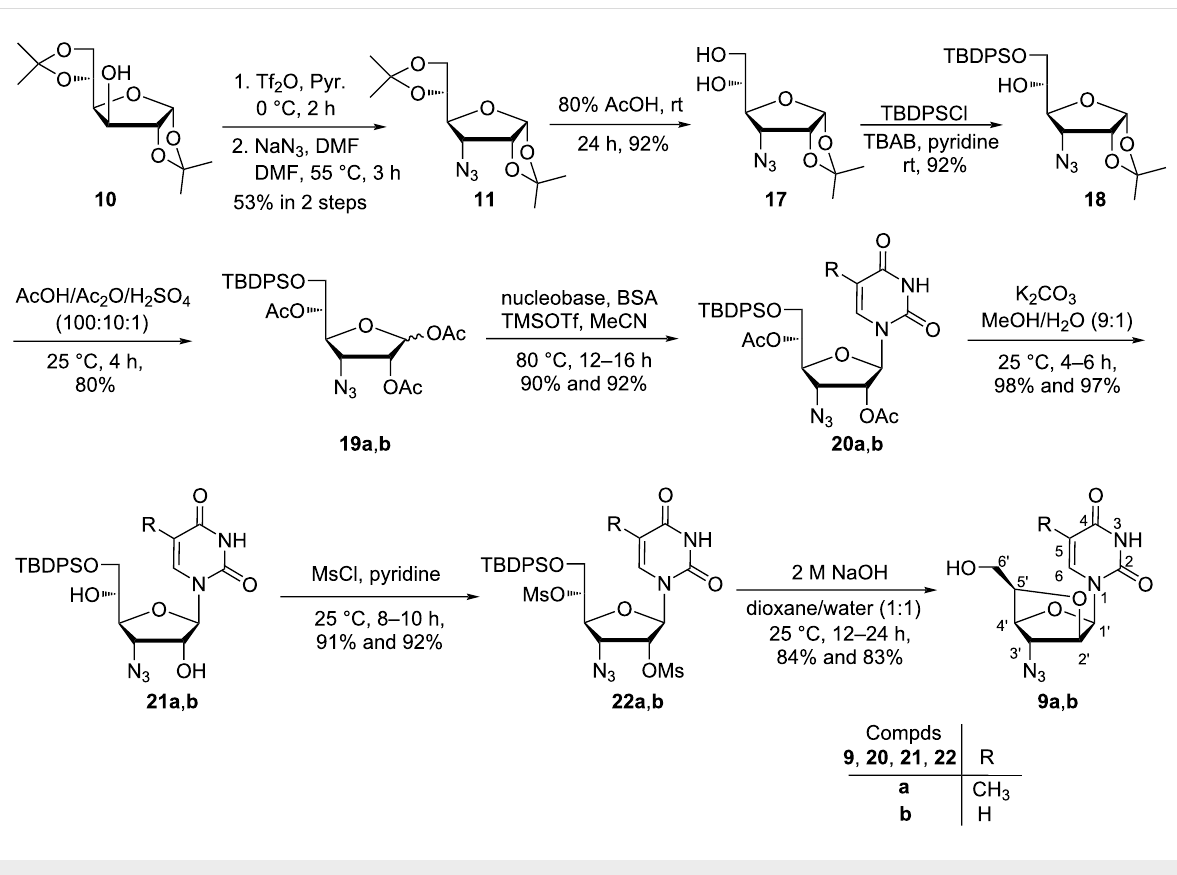
moieties [32-34]. Herein, we elucidated the mechanistic path- way for conversion of 16a , b into 9a , b through the formation of an intermediate epoxide II, which has ( S ) stereochemistry at the C5 ′ due to first inversion of configuration by attack from the C6 ′ -OH group (Scheme 6). The second inversion at the C5 ′ centre occurred when the C2 ′ -OH attacked the same chiral centre and opened the epoxide ring by S N 2 reaction and inverted the configuration of the centre into ( R ). In the chemi- cal route for synthesis of bridged nucleosides 9a , b , an